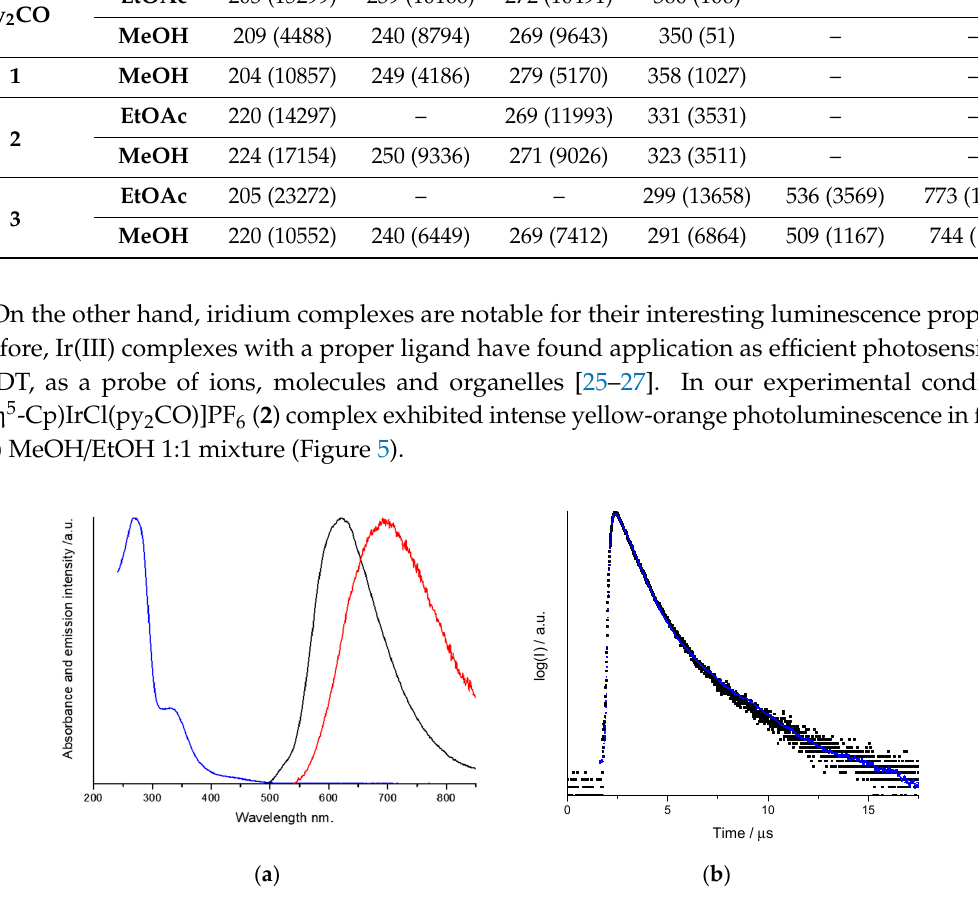
Figure 5. ( a ) Band profile of UV-Vis absorption spectrum for [( η 5 -Cp)IrCl(py 2 CO)]PF 6 ( 2 ) complex recorded in dichloromethane solution (blue line). Band profiles of emission spectra recorded at room temperature in dichloromethane solution (red line) and in 77 K MeOH/EtOH 1:1 matrices (black line). ( b ) Emission decay profiles recorded for complex 2 (black scattered line) and the fitted decay curve (black scattered line). Data for the 77 K measurements in MeOH/EtOH 1:1 matrices. For complex 2 ( λ em = 620 nm), bi-exponential decay was observed with two life-time values, with a short-lived ( τ 1 = 0.02 (0.07) μ s) and long-lived component ( τ 2 = 0.83 (0.93) μ s), respectively. Bi-exponential decays with two τ em values were fitted according to the I em (t) = A 1 exp(-t/ τ 1 ) + A 2 exp(-t/ τ 2 ) relationship. Values given in parentheses next to the life-time values correspond to the contribution of the short-lived A 1 τ 1 /(A 1 τ 1 + A 2 τ 2 ) and the long-lived A 2 τ 2 /(A 1 τ 1 + A 2 τ 2 ) components of the overall emission quantum yields. The short-lived emission component occurs with very small contribution to the overall emission intensity, whereas the long-lived component is predominant. The data for a solution of 2 in acetonitrile or dichloromethane at room temperature displayed the emission band ca. 700 nm with low quantum yields ( ϕ em ) equal to 0.03% or 0.04%, respectively. Complex 3 at 77 K in alcohol glass exhibited very weak and structured emission for which it was impossible to estimate the τ em value. Notably, compared to complex 2 with the κ N,N’ coordination mode of py 2 CO, the emission of 3 is very weak, probably due to the directly bonded oxygen (of C=O) with the iridium ion in the κ N,O mode of coordination of py 2 CO. 3.3. Biological Activity of the Complexes 3.3.1. Solution Stability and Lipophilicity The stability of complexes in solution and lipophilicity play a crucial role in the process of developing a new drug. In our experiment, the UV-Vis and 1 H NMR spectroscopies were used over a period of 48 h to monitor the stability of the complexes in a Tris-HCl/NaCl buffer and DMSO, respectively. In the spectra of complex 2 (Figure 6), we observed decreasing intensity of spectral bands, while in spectra of complexes 1 , 3 the characteristic bands are slightly red shifted (e.g., 223 → 225 nm, 261 → 263 nm, respectively).